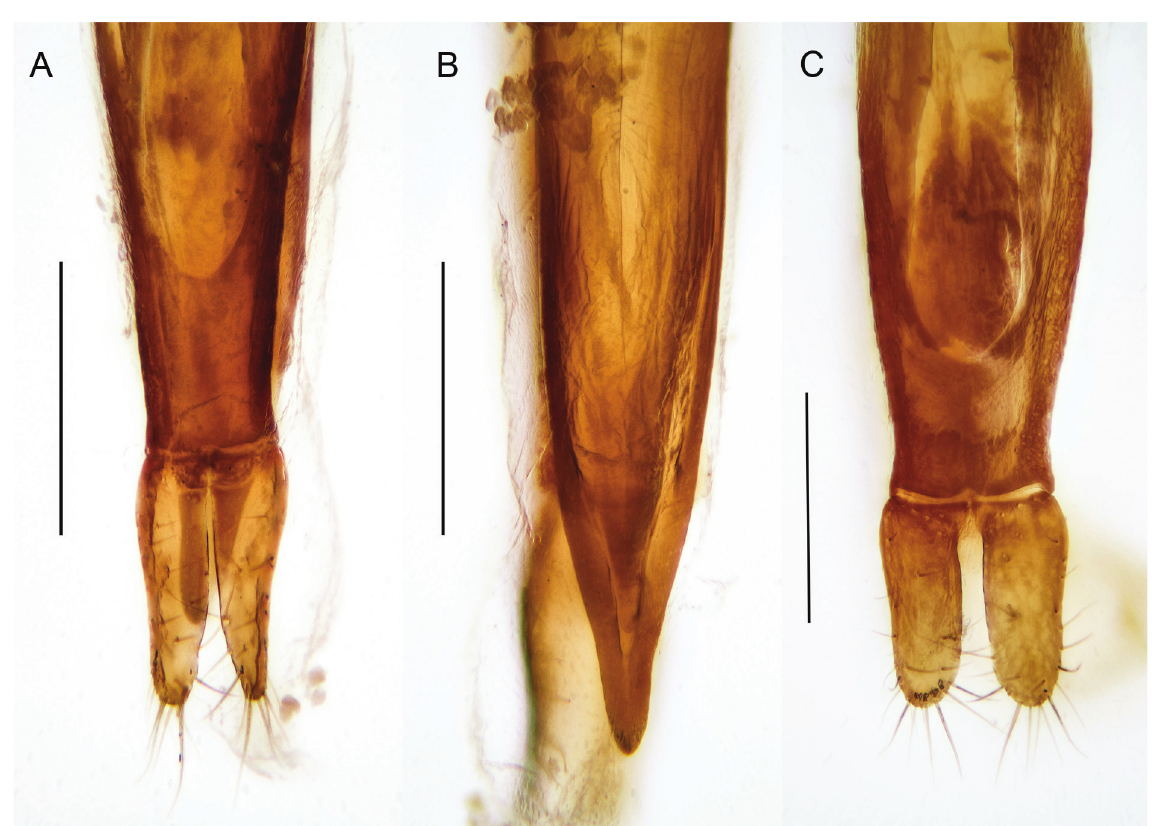
Fig. 14. Bolianus giannae gen. et sp. nov. A–B . Holotype, detail of aedeagus. A . Parameres, ventral view. B . Median lobe, dorsal view. — C . Paratype, parameres, ventral view. Scale bars = 0.2 mm.